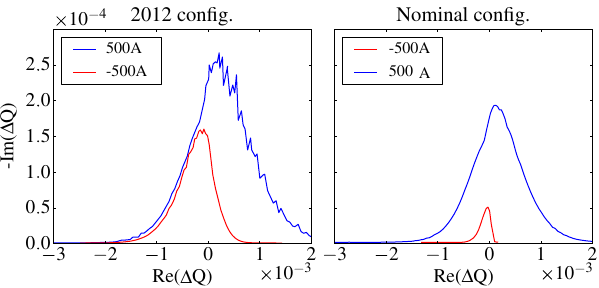
FIG. 7. Comparison of the worst bunch at the end of the squeeze for each polarity of the octupole, in 2012 and nominal configurations.